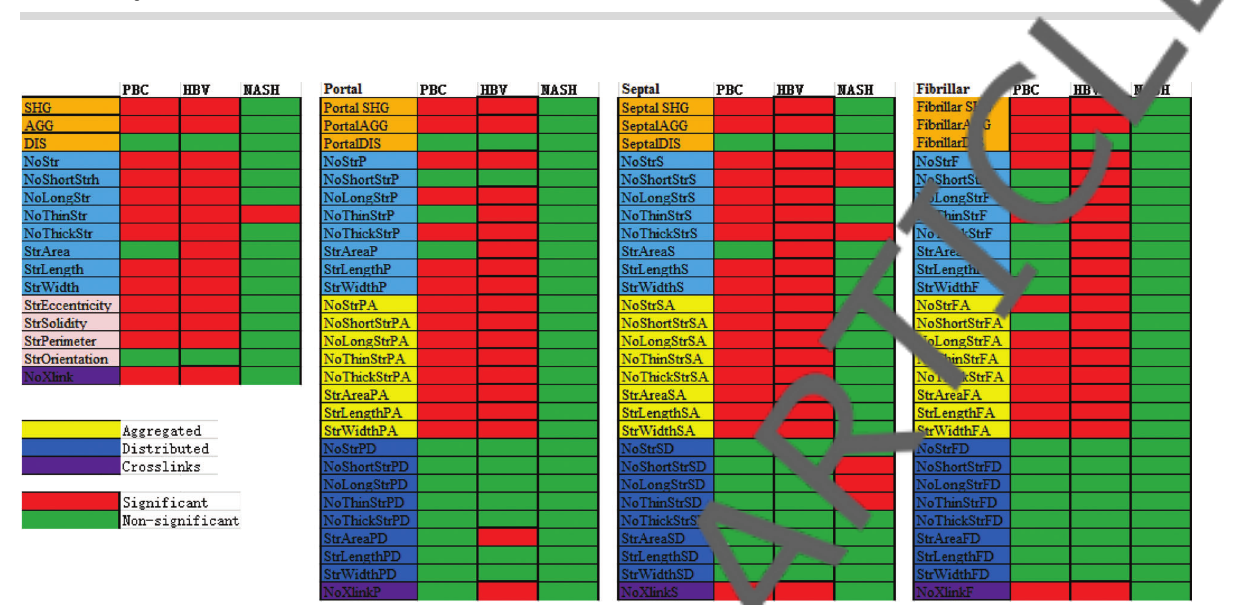
Figure 2. Spearman correlation analysis of parameters in portal, septal and fi brillar areas with stages for chronic hepatitis B (CHB), primary biliary cirrhosis (PBC) and non-alcoholic steatohepatitis (NASH). Orange, light blue and gray colors are used for differentiation of different parameters. SHG, second harmonic generation; AGG, aggregated collagen percentage; DIS, distributed collagen percentage. See Supplementary Table S1 for details.